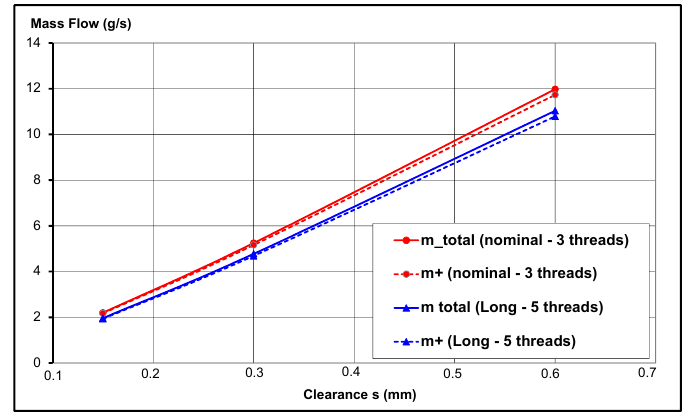
Figure 15. Mass flow rates through the windback seal at 15,000 rpm using different clearance and thread sizes.